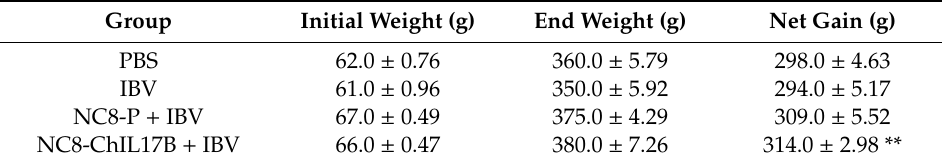
Table 3. The chickens’ weight over the 28 days vaccination